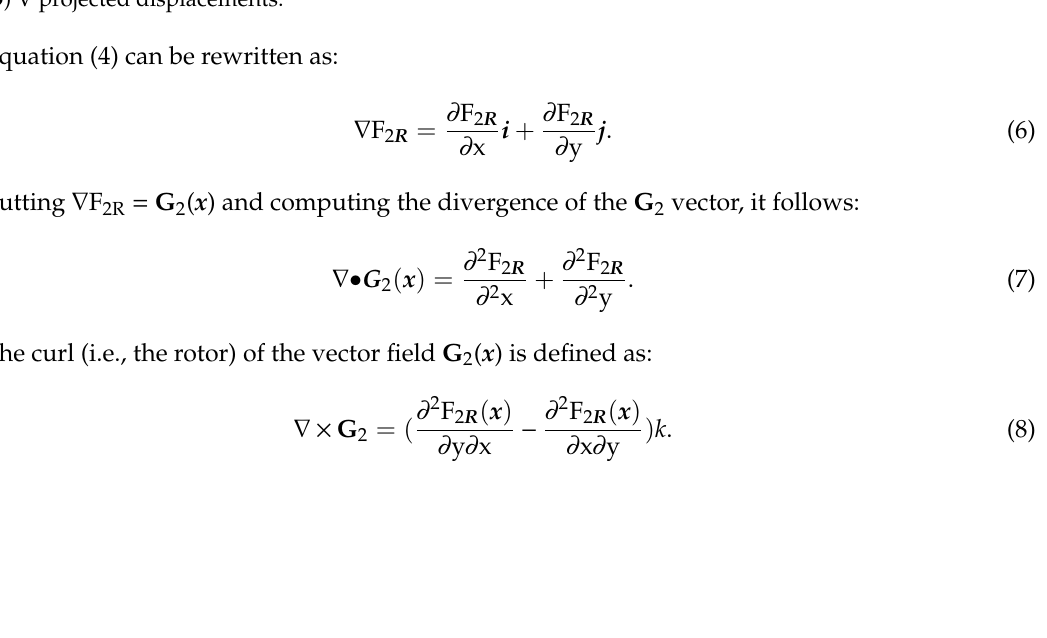
Figure 4. Schematic of local gradients vectors and corresponding Cartesian components for ( a ) U and ( b ) V projected displacements.